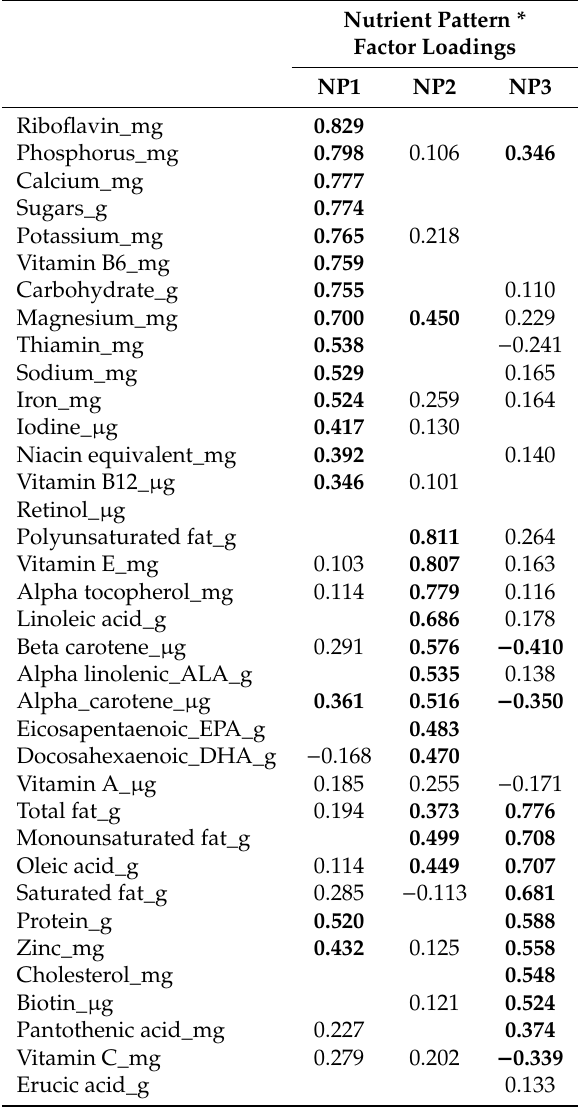
Table 2. Factor loading matrix for the nutrient patterns of 101